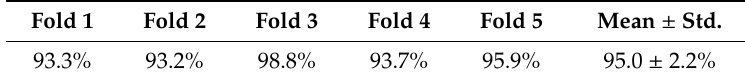
Table 1. Classification Accuracy of the Proposed